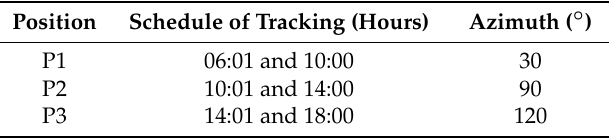
Table 2. Azimuth schedule of tracking.